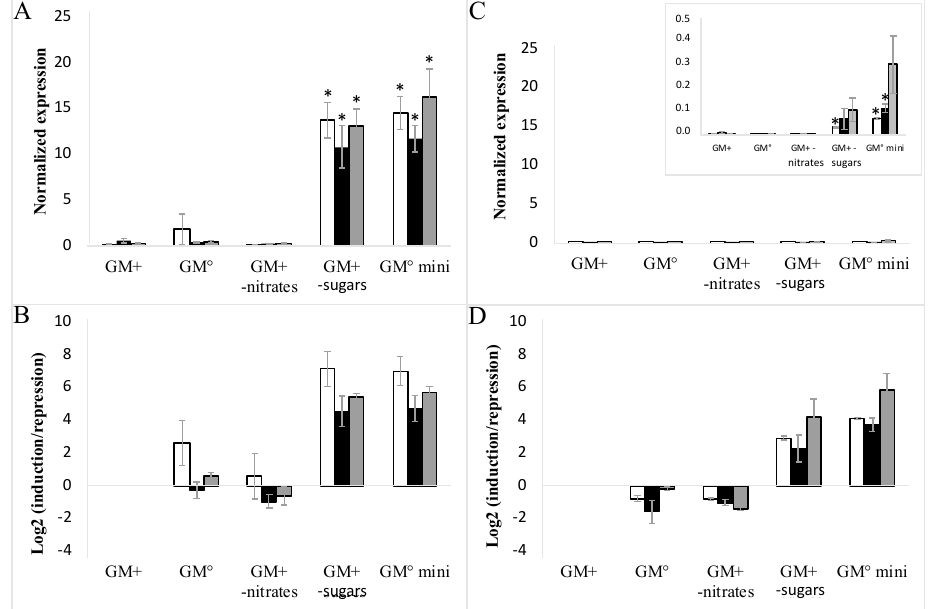
Figure 5. Influence of cell culture media composition on the expression of VvHT1 and VvHT5 in embryogenic cells (EC). Complete medium (GM + ), medium without auxins (GM ◦ ), medium without nitrates (GM + w/o nitrates), medium without maltose and glycerol (GM + w/o sugars), medium without auxins, nitrates, maltose and glycerol (GM ◦ mini). (cid:3) -WT; (cid:4) -VvMSA-OE; (cid:4) -VvMSA-RNAi. The gene expression of VvHT1 ( A , B ) and VvHT5 ( C , D ) is normalized to that of the housekeeping gene VvActin reported to the control condition used to calculate the ratio of induction/repression. Normalized expression ( A , C ) and induction/repression ( B , D ) are calculated by the methods of ∆ Ct and 2 − ∆∆ CT respectively. The presented results correspond to the mean values of three independent experiments ( ± SEM). The asterisks denote the groups that were found significantly different by Kruskal–Wallis test (* p <